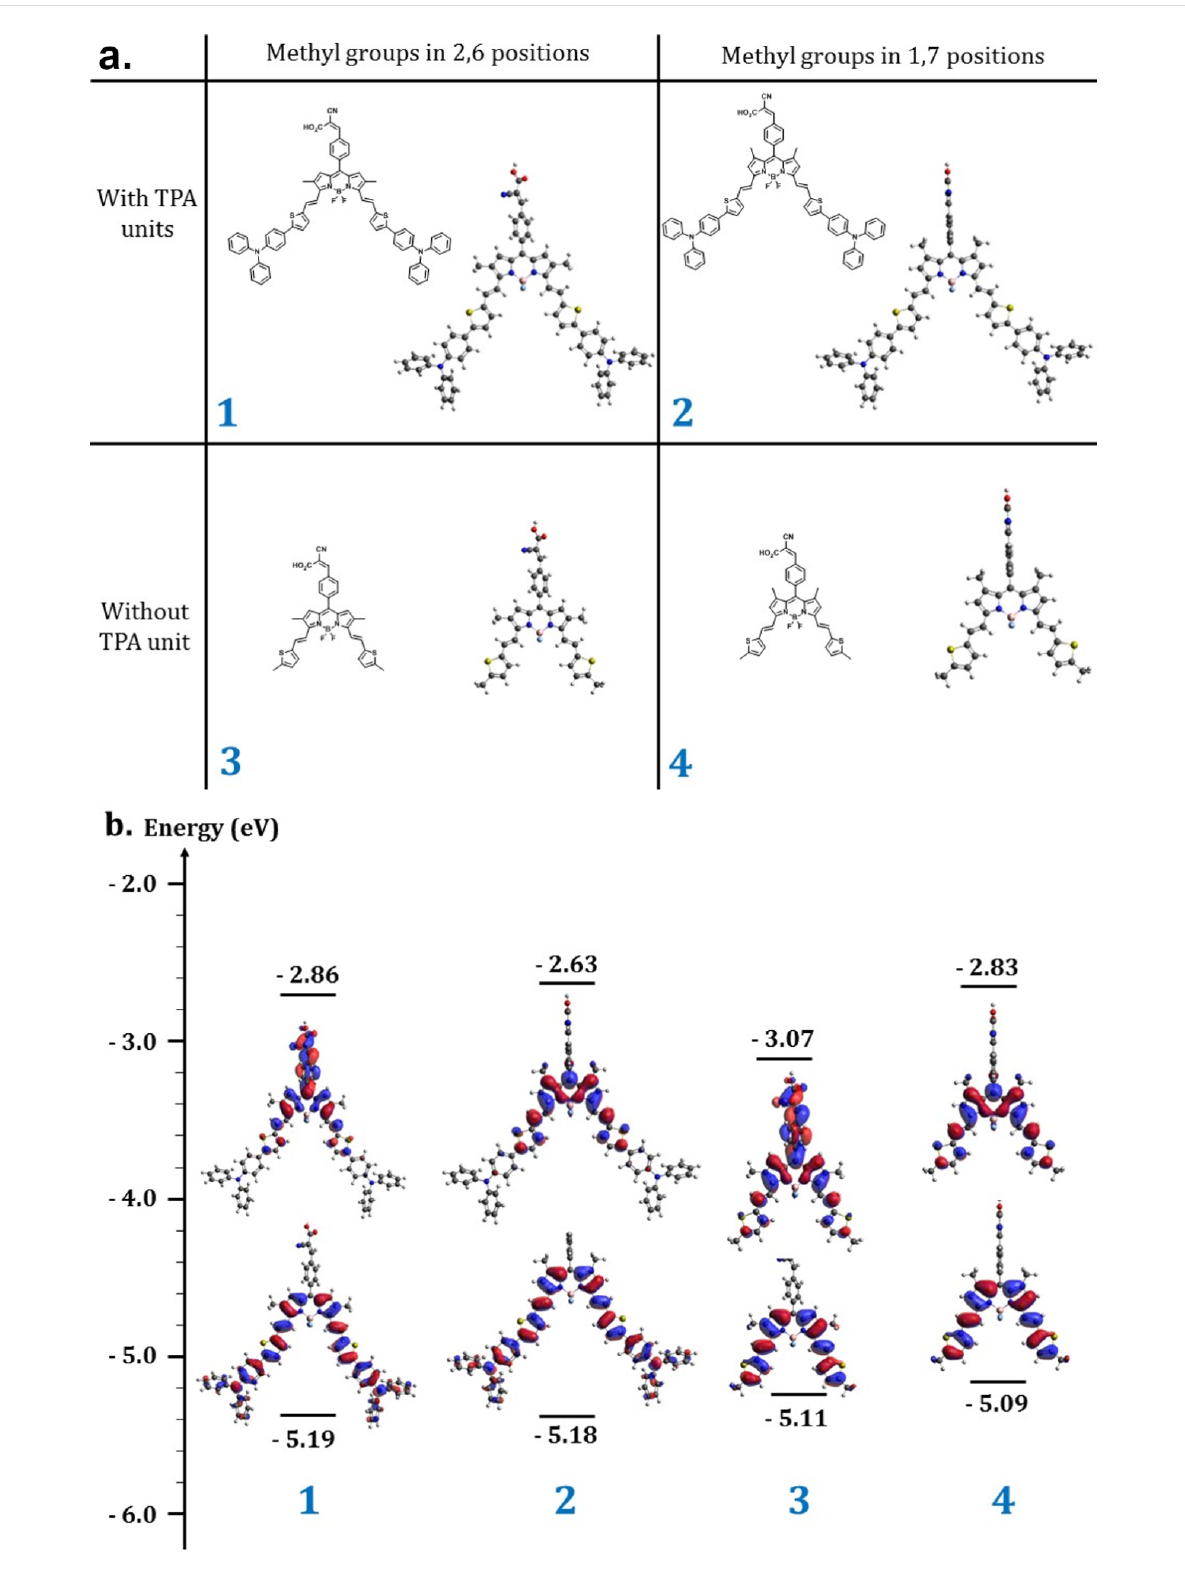
Figure 2: a) Geometrical optimization of four representative BODIPY-based materials for DSSCs application. b) Frontiers molecular orbitals reparti- tion and their predicted energy values for the selected four representative BODIPY-based